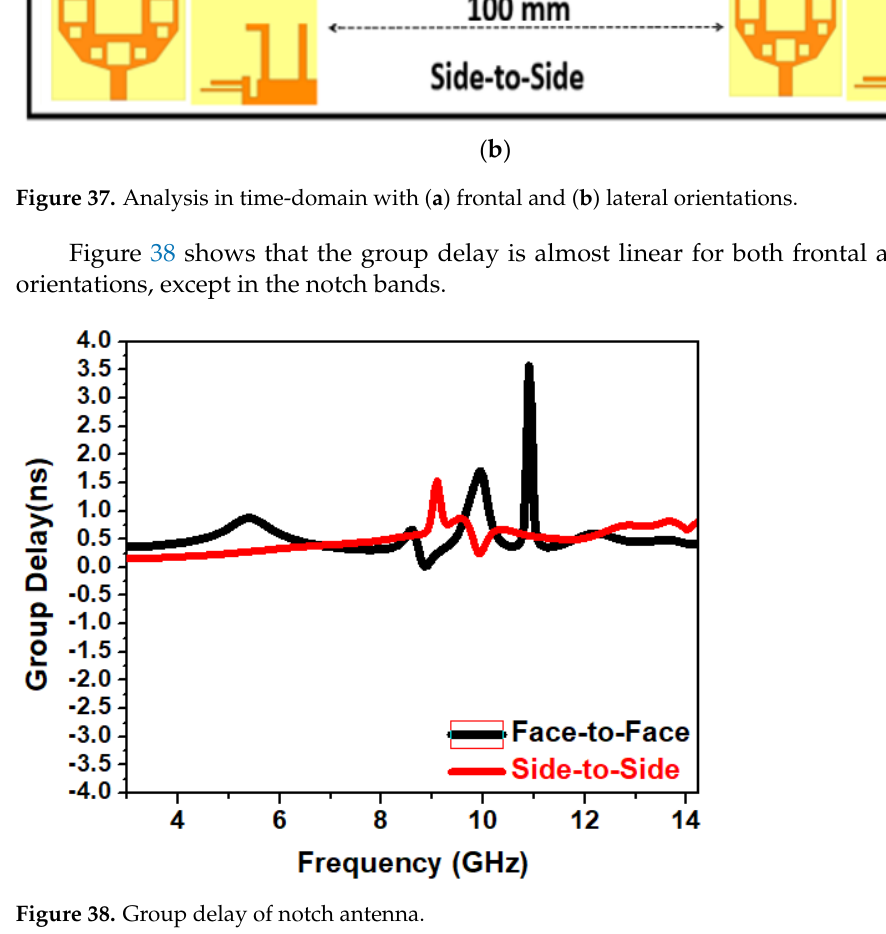
Figure 38. Group delay of notch antenna. Figure 39 shows that the designed notch antenna has frontal and lateral isolation characteristics that are considered to be